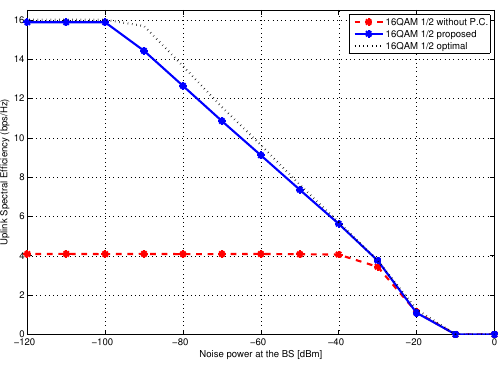
Figure 9. Spectral efficiency for 16QAM-1/2 versus noise